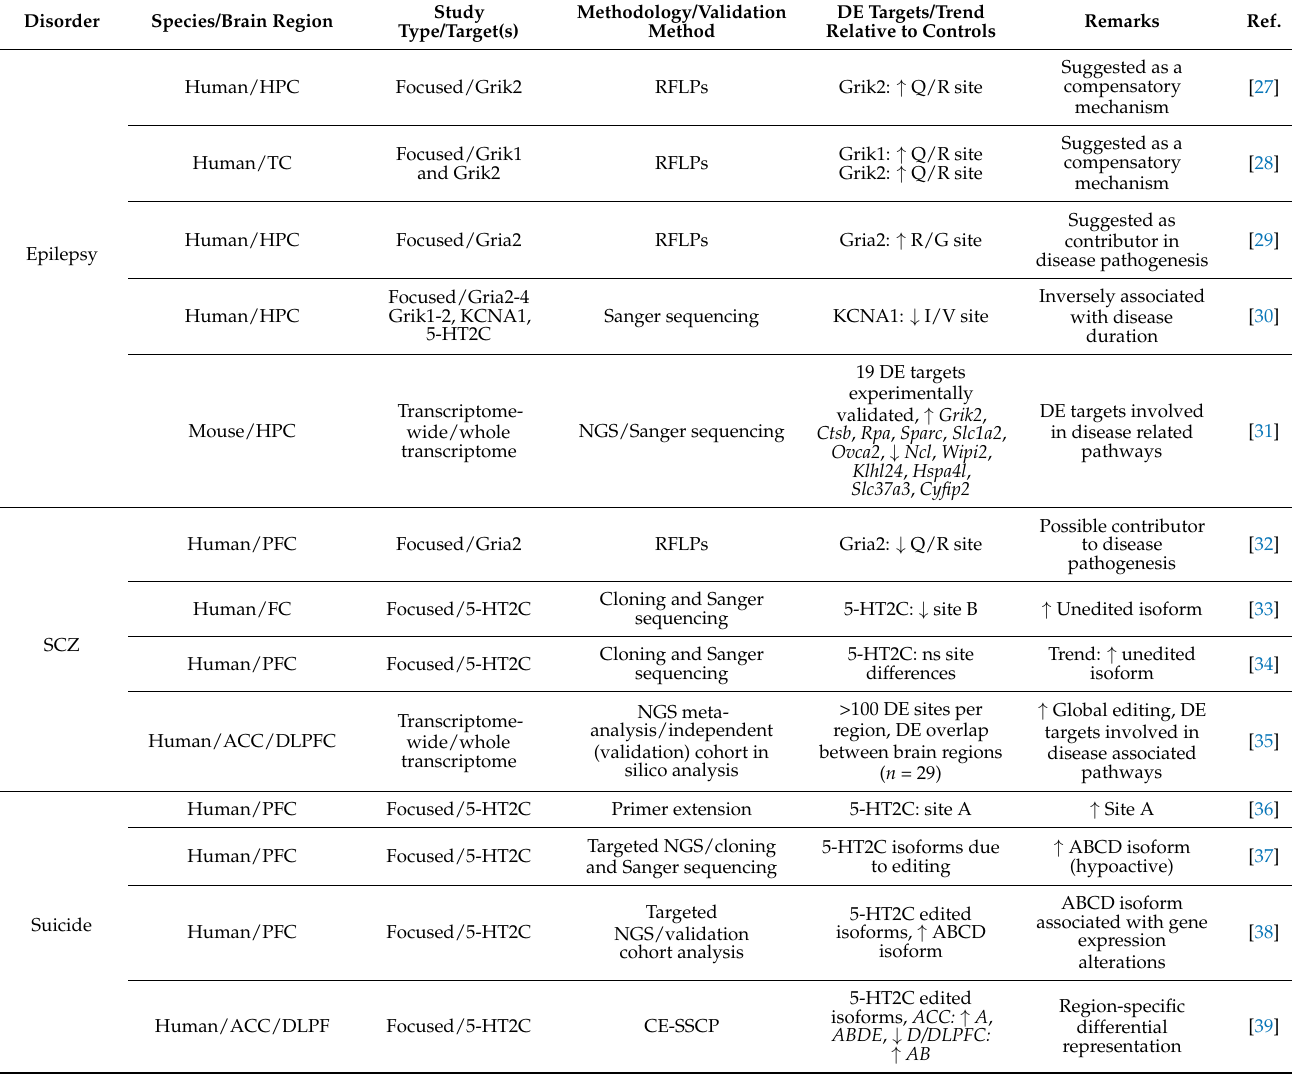
Table 1. Studies of RNA editing alterations in neurological and psychiatric disorders, utilizing either human postmortem or murine mouse models central nervous system (CNS) material. DE: differentially edited, SCZ: schizophrenia, CSDS: chronic social defeat stress, HPC: hippocampus, TC: temporal cortex, FC: frontal cortex, ACC: anterior cingulate cortex, DLPFC: dorsolateral prefrontal cortex, PFC: prefrontal cortex, BLA: basolateral amygdala, CB: cerebellum, RFLPS: restriction frag- ment length polymorphism, NGS: next-generation sequencing, CE-SSCP: capillary electrophoresis single-stranded conformational polymorphism, DHPLC: denaturing high performance liquid chro- matography, mmPCR_seq: microfluidics multiplex polymerase chain reaction and deep